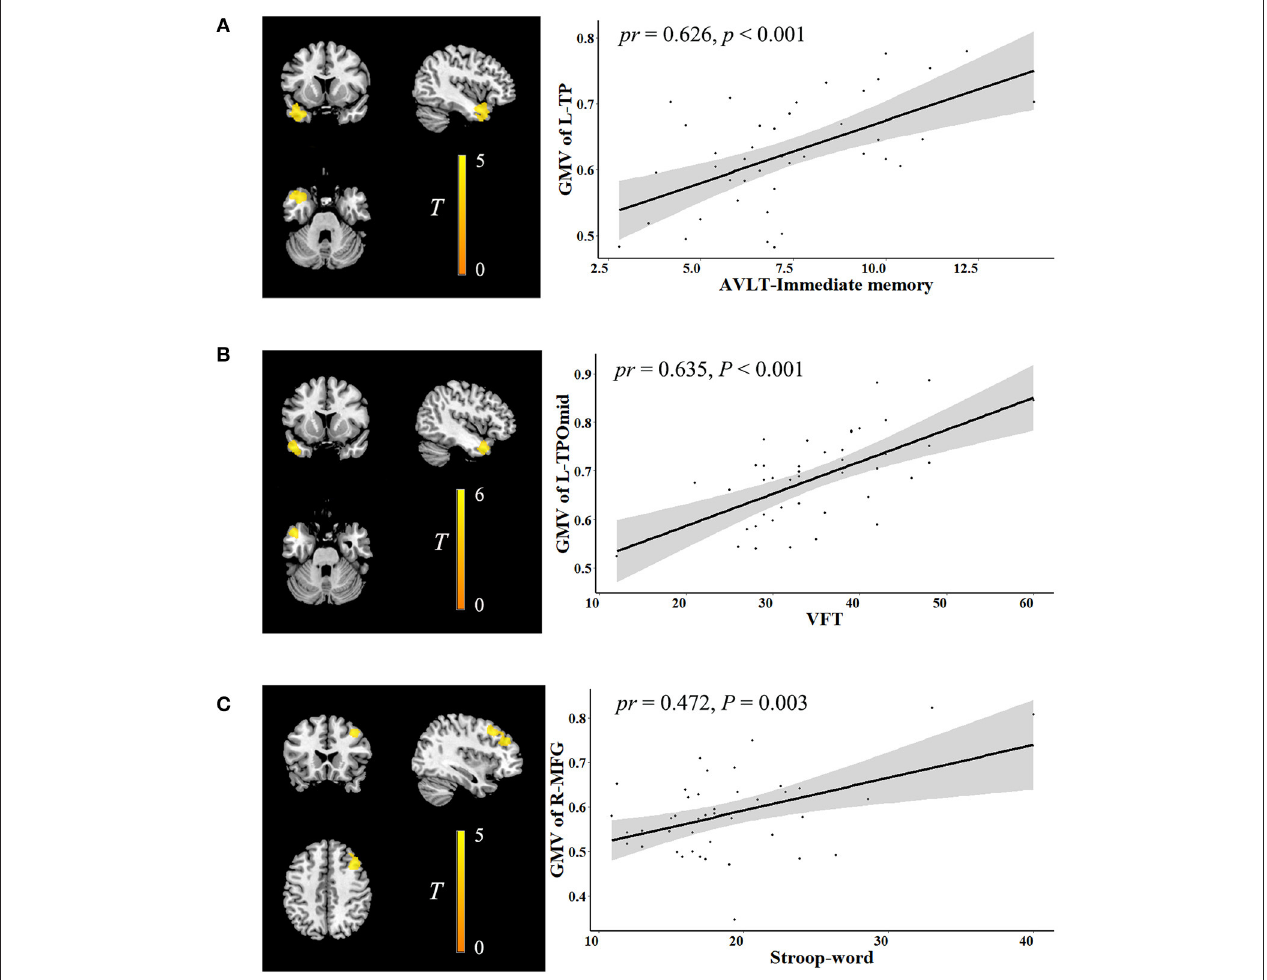
FIGURE 1 | Correlation between neurocognition and GMV. The left figure in (A–C) is voxel-based and the right is ROI-based. (A) Correlation between GMV in the left TP and AVLT-immediate recall. (B) Correlation between GMV in the left TPOmid and VFT. (C) Correlation between GMV in the right MFG and stroop-word. GMV, gray matter volume; ROI, region of interest; TP, temporal pole; AVLT, auditory verbal learning test; TPOmid, temporal pole: middle temporal gyrus; VFT, verbal fluency test; MFG, middle frontal gyrus; pr , partial correlation coefficient; L, left; R,